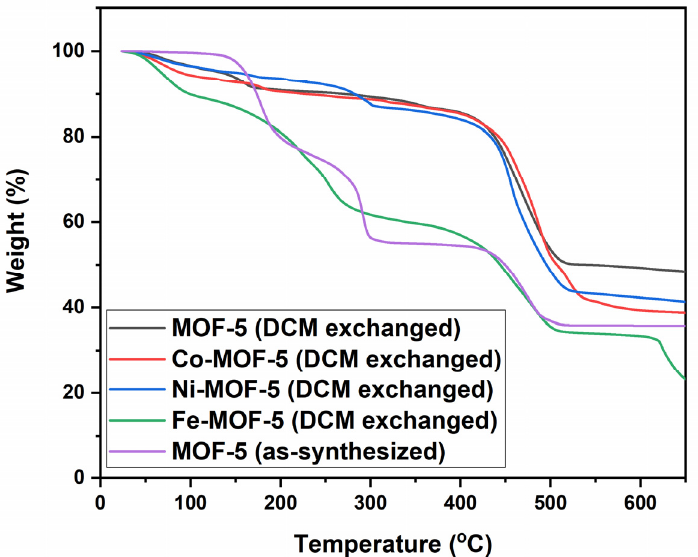
Figure 6. Thermogravimetric analysis of the MOF-5 (as-synthesized) and DCM - exchanged